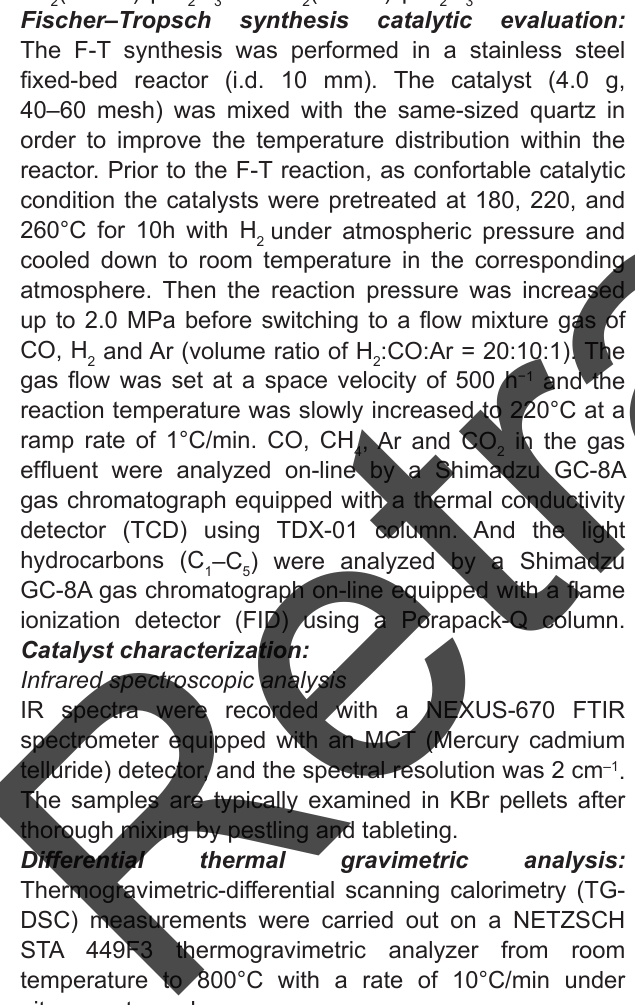
Fig. 1. TG curve of the (CO)